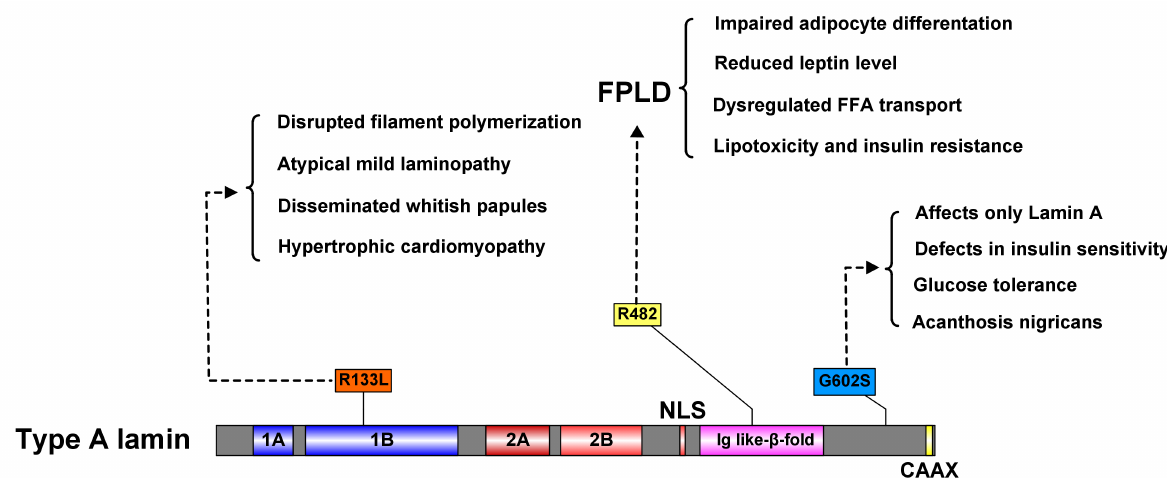
Figure 2. LMNA mutations associated with diabetes mellitus (DM). R482 mutation leads to Dunnigan-type familial partial lipodystrophy (FPLD), showing symptoms such as subcutaneous fat loss, glucose intolerance, hypertension, and insulin resistance that eventually lead to DM. R133L mutation leads to atypical mild laminopathy, showing lipodystrophy and insulin resistance that are characteristic of type A insulin resistance syndrome. G602S mutation affects only lamin A protein and leads to insulin sensitivity, glucose tolerance and acanthosis nigricans, and is significantly associated with T2DM